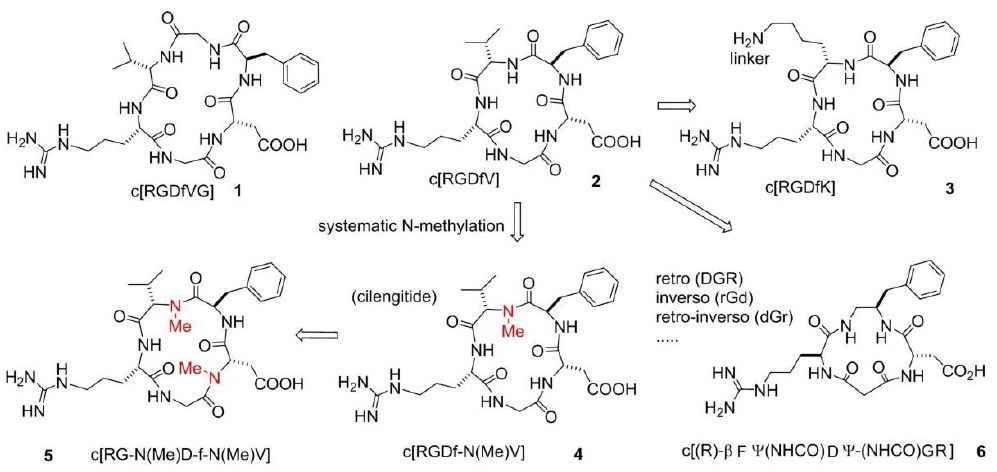
Figure 2. Examples of cyclopeptide integrin ligands: c[RGDfVG], and c[RGDfV], from which derive